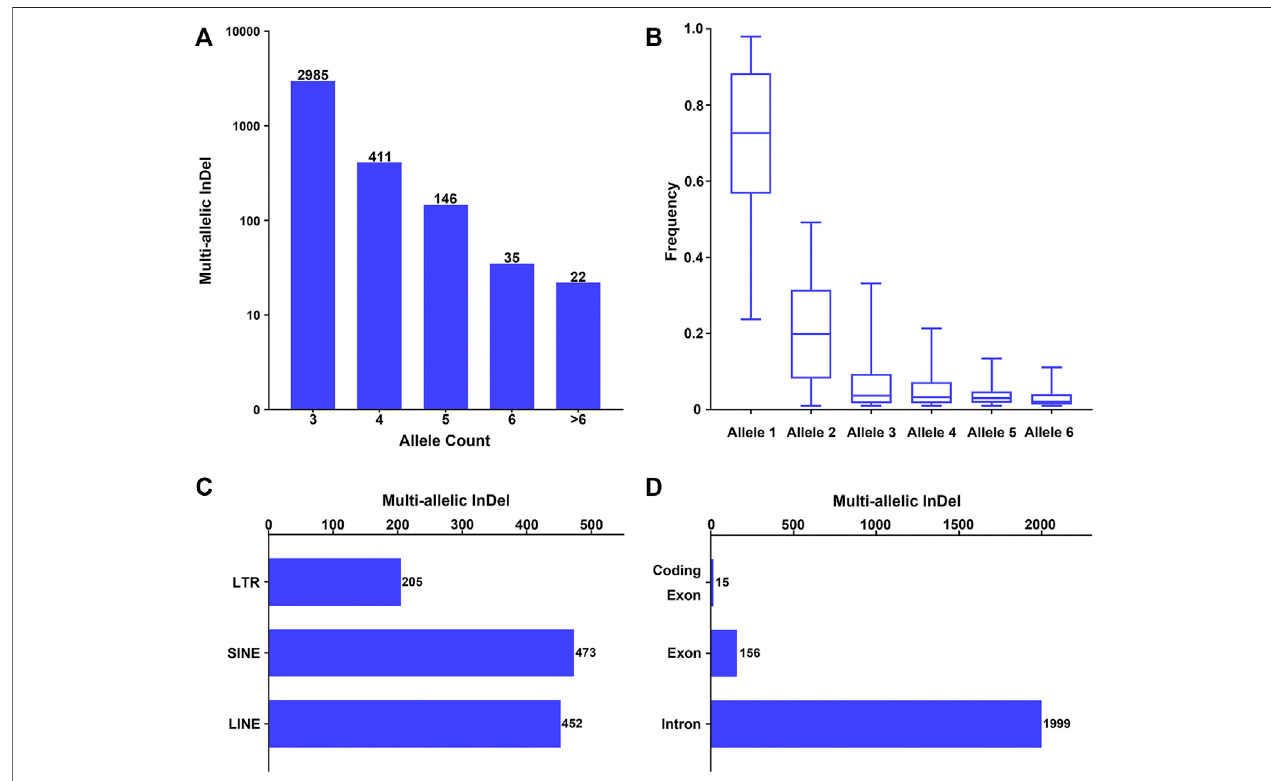
FIGURE 1 | Investigation of multi-allelic InDels with random sequences across the genome. (A) Number of multi-allelic InDels with random sequences with relative allelecounts.Alleleswithallelefrequency > 0.01wereconsideredasvalidalleles. (B) Frequencydistributionofmultipleallelesatthemulti-allelicInDels.Allelesweresorted in a descending order by frequency in the global population at each multi-allelic InDel marker. Alleles with the 6 highest frequencies were referred to as alleles 1 – 6. (C) Genomic distribution of the multi-allelic InDels with random sequences located in repeat elements. LTR , long terminal repeat; SINE , short interspersed element; LINE , long interspersed element. (D) Genomic distribution of the multi-allelic InDels with random sequences located in annotated human